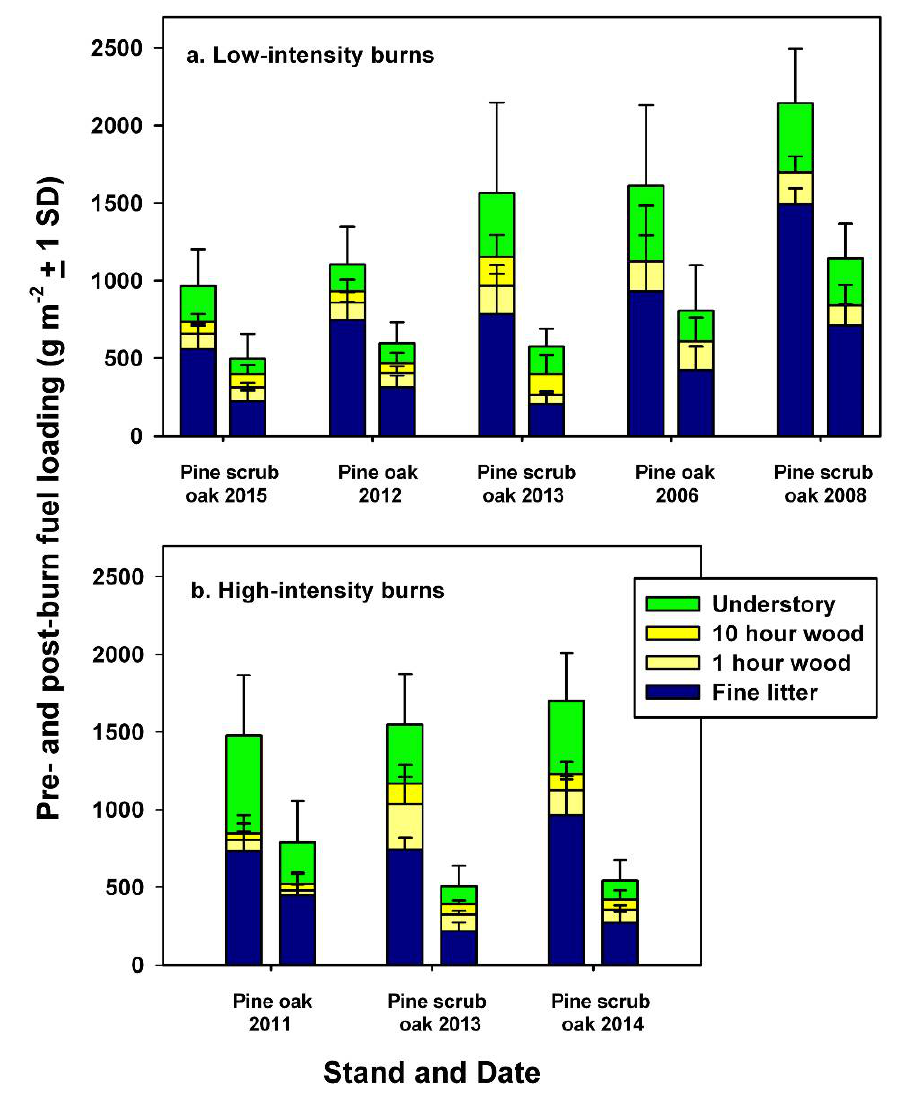
Figure 2. Pre- and post-burn fuel loading for the eight prescribed fires, partitioned into understory, 1 hour and 10 hour wood, and fine litter. Fuel loadings are presented for ( a ) low-intensity burns and ( b ) high-intensity burns. Table B1 presents source fuel loading values.